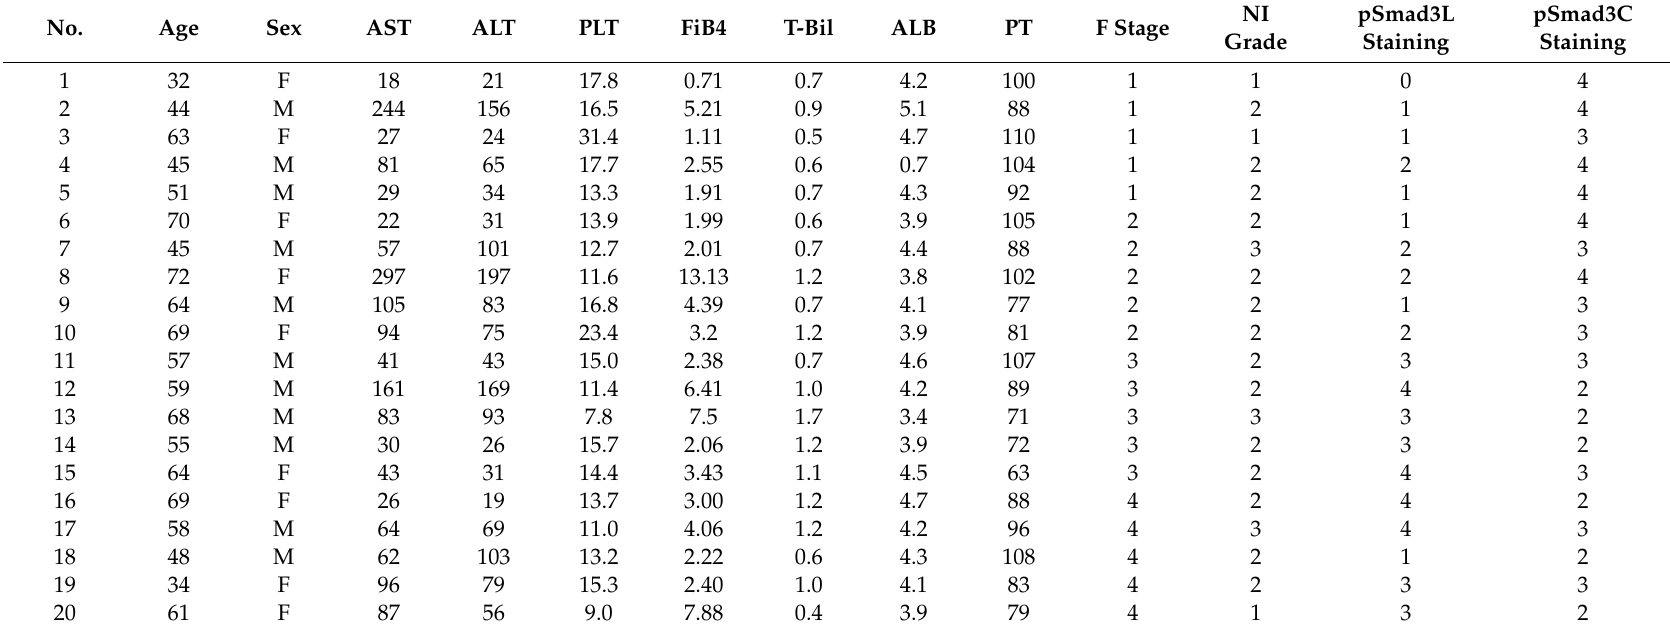
Table 2. Clinicopathologic features and Smad3L / C phosphorylation in liver specimens from patients with hepatitis C virus